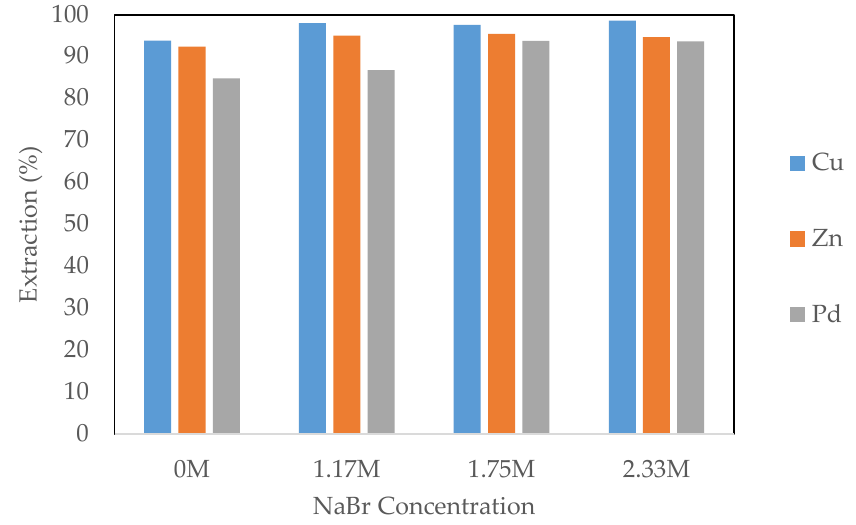
Figure 10. Dissolution of base metals (Cu and Zn) and palladium at various concentrations of sodium bromide (0.78 M Br 2 , 23.5 °C and natural pH).